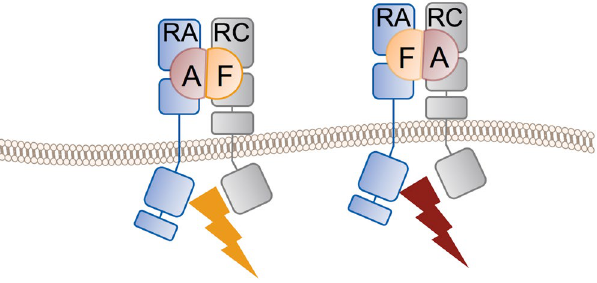
Figure 7. Schematic representation of the two, topologically distinct, signaling complexes potentially formed by the human IL-17A/F heterodimer and the IL-17RA and IL-17RC receptor chains. Whether both complexes are competent for signaling and whether they trigger the same downstream signaling events is not